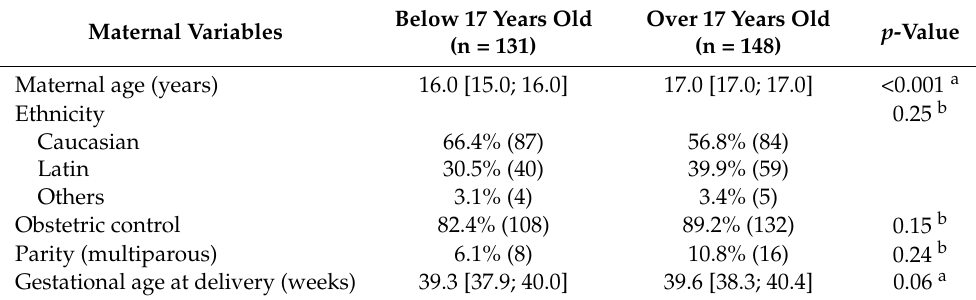
Table 1. Maternal variables during pregnancy according to maternal